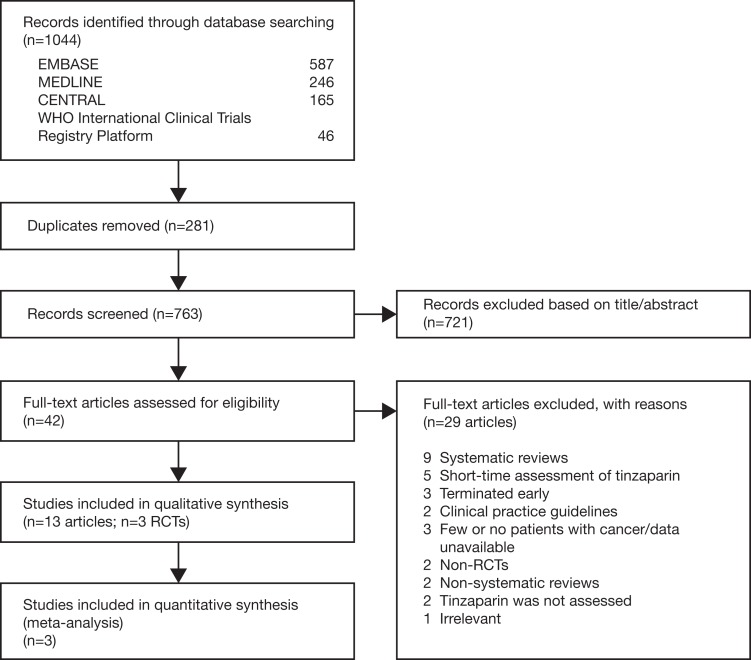
PRISMA flow diagram.